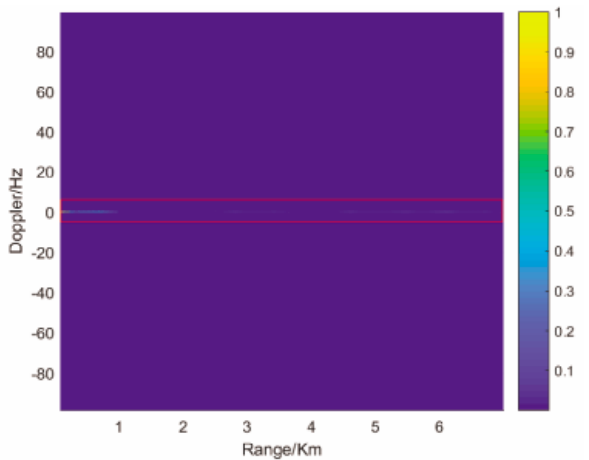
Figure 4. RD map based on Fourier transform (FT) without clutter cancellation.